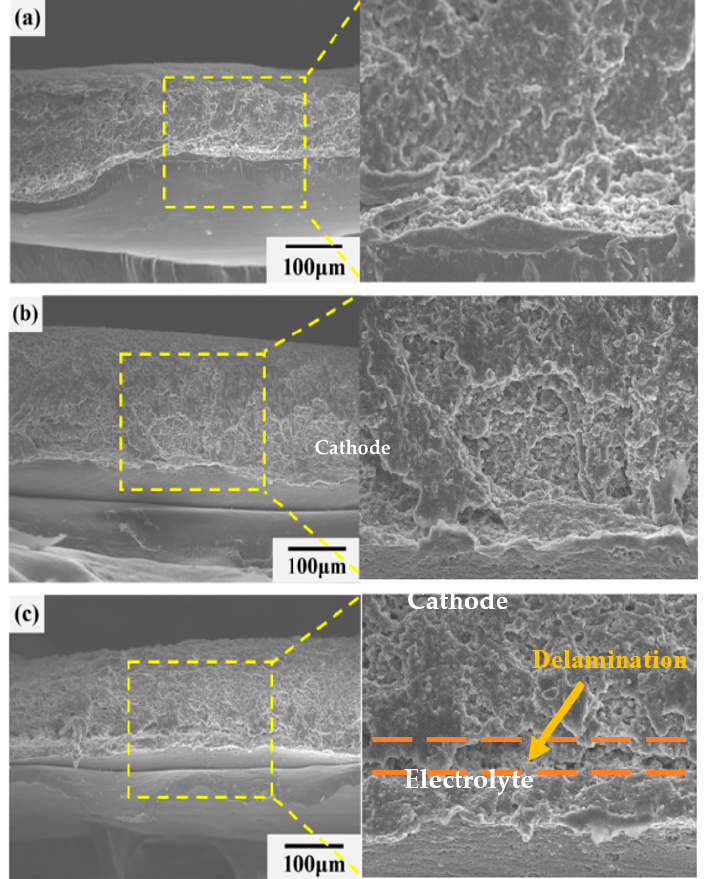
Figure 3. FE-SEM images of composite cathode sheets with different LiTFSI contents: ( a ) LiTFSI-0%, ( b ) LiTFSI-3%, and ( c ) LiTFSI-4% on a LATP/PVDF-HFP electrolyte membrane.